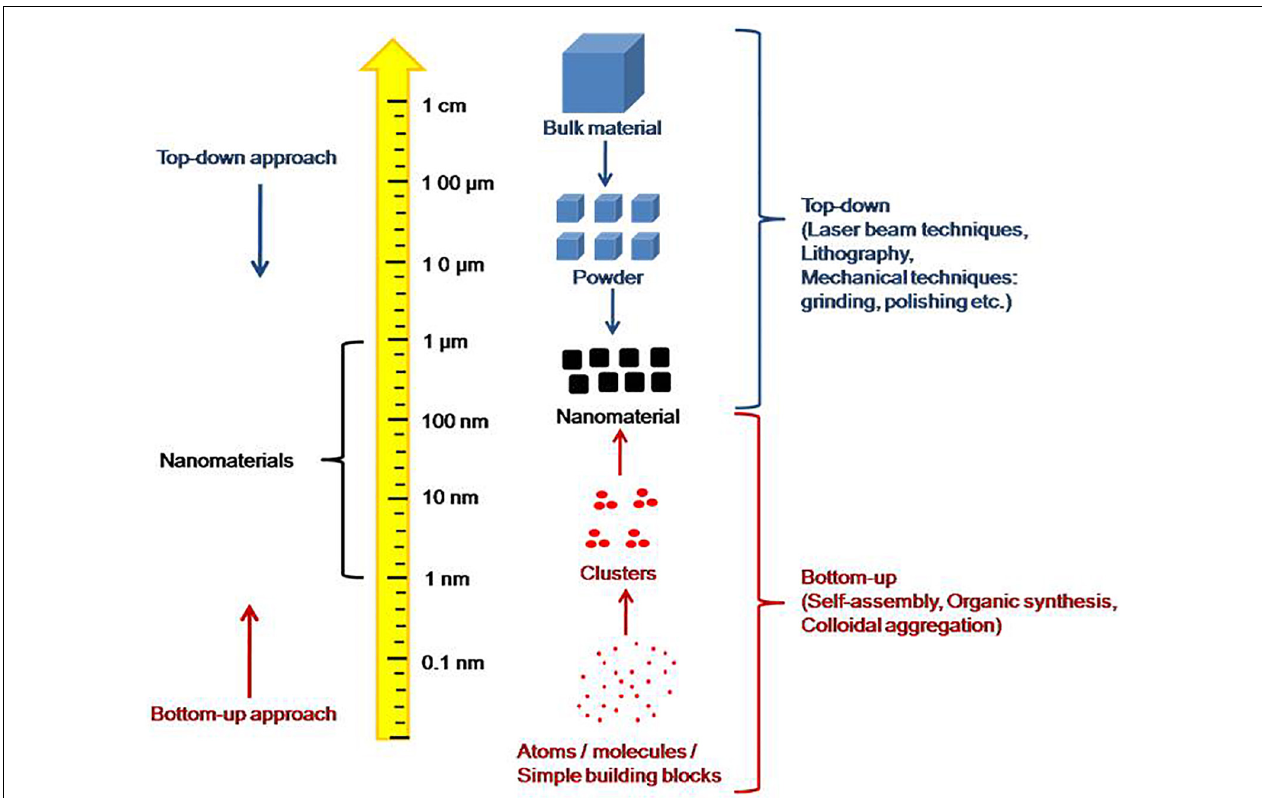
FIGURE 1 | “Top-down” and “bottom-up” approaches of